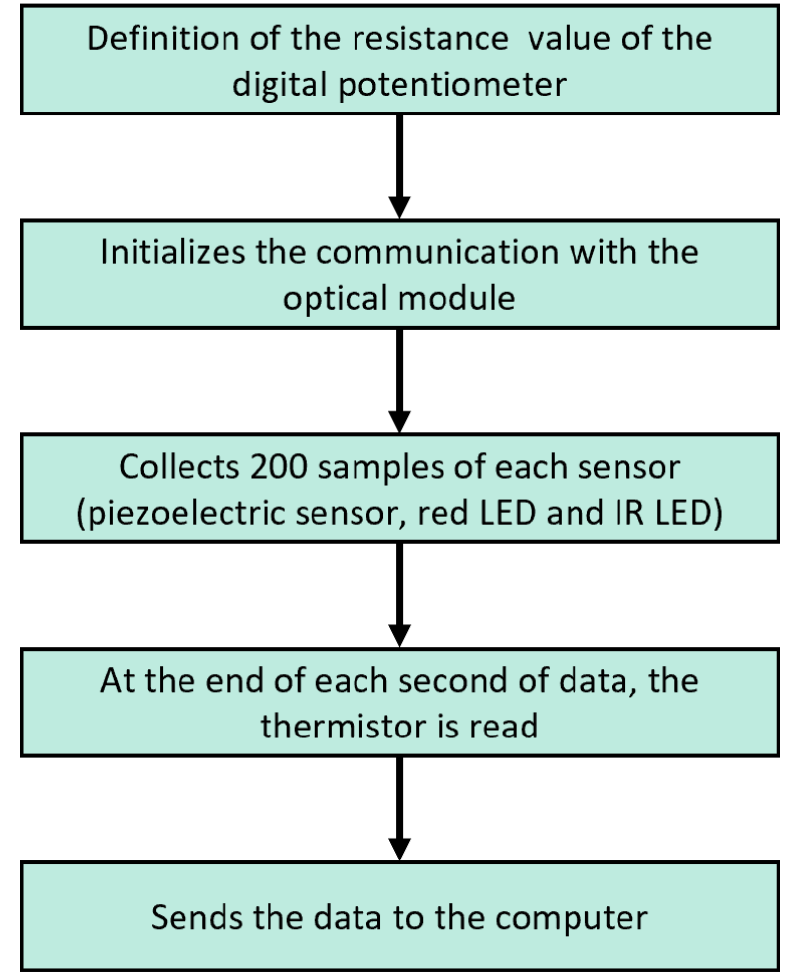
Figure 6. Firmware schematic.